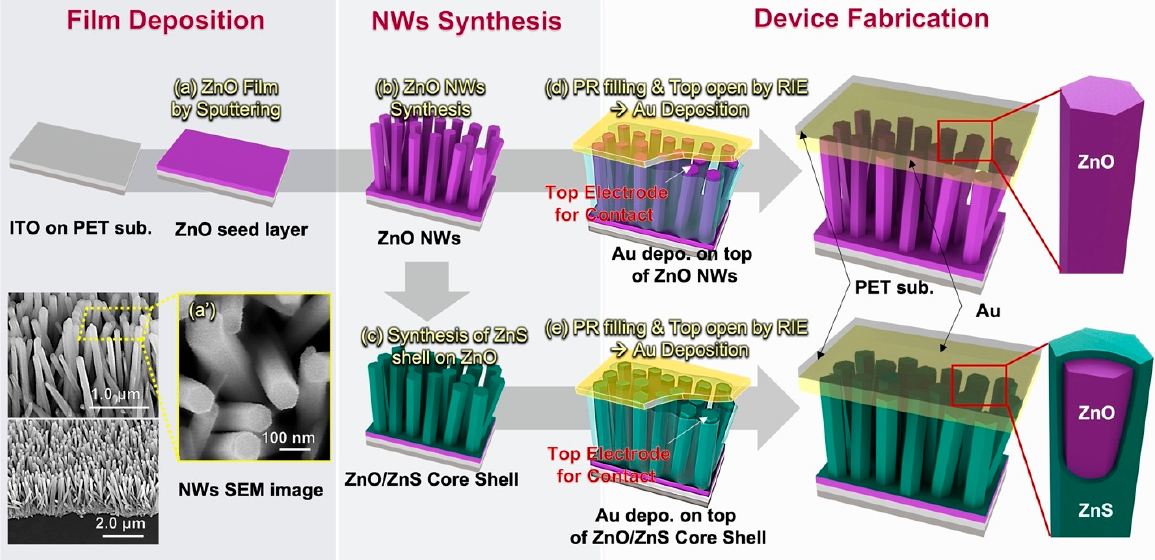
Figure 1. Schematic illustration of the fabrication process of the ZnO and ZnO/ZnS core/shell nanowire (NW)-based devices. ( a ) Preparation of substrate by deposition of ZnO seed layer by RF sputtering on ITO-coated PET substrate. ( a ′ ) Top view of scanning electron microscopy (SEM) image of ZnO NW array on substrate. ( b ) ZnO NW array grown using hydrothermal methods, and ( c ) ZnO/ZnS core/shell NW array achieved by synthesis of ZnS shell. ( d ) The ZnO and ( e ) ZnO/ZnS core/shell NW array devices fabricated by Au electrode deposition after RIE processing for opening of spin-coated photoresist layer.